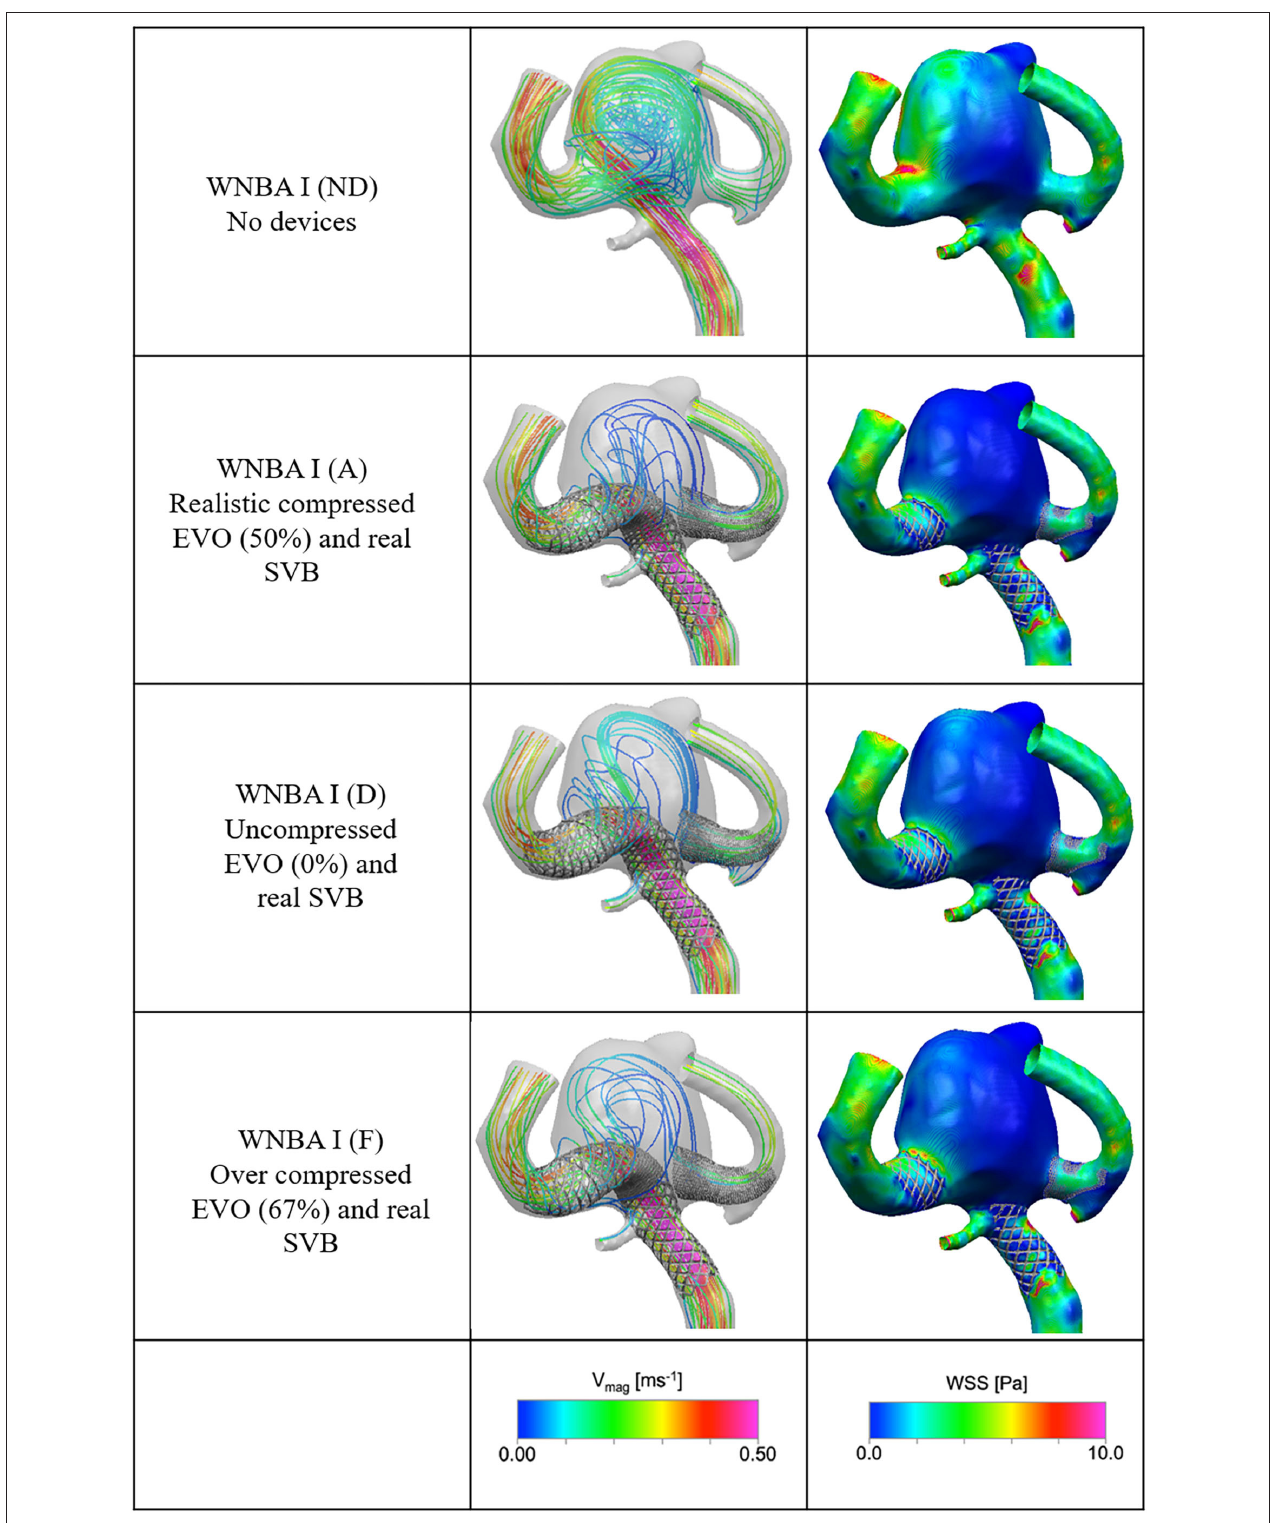
FIGURE 6 | Velocity streamlines and WSS distributions for the No Device (ND) and selected device configurations (cases A, D, and F) for the WNBA I geometry.